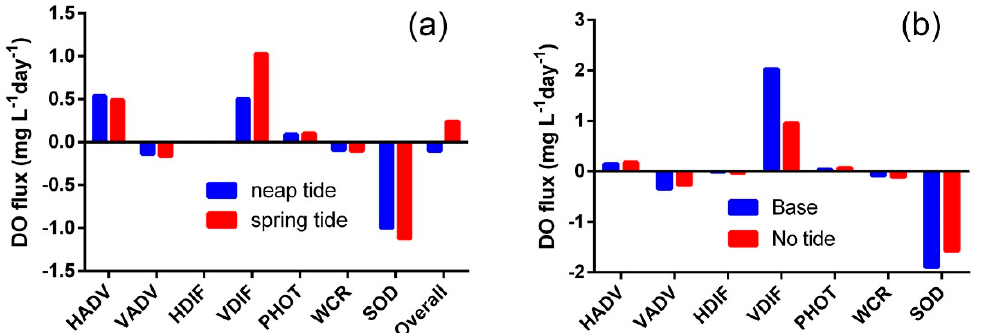
Figure 16. ( a ) DO budget of the WindConst run in the bottom layer of the Modaomen hypoxic zone during neap and spring tide; and ( b ) DO budget of the base and no-tide runs in the bottom layer of the PRE during June–August.